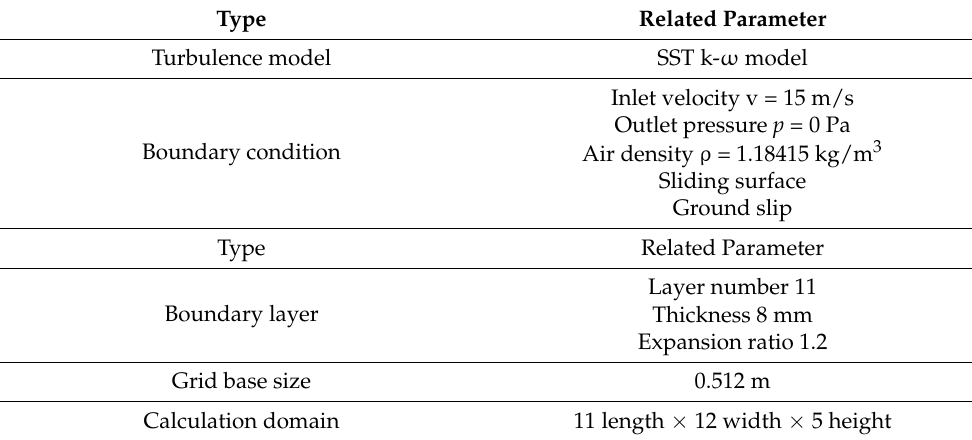
Table 1. Final simulation strategy.